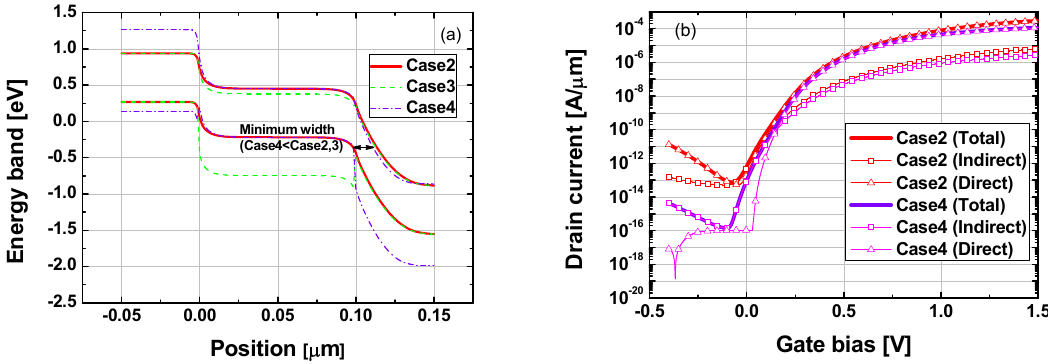
Figure 4. ( a ) Energy band diagrams for comparing Case2–Case4 at off-state ( V GS = − 0.4 V, V DS = 0.95 V). ( b ) Indirect tunneling, direct tunneling and total drain current of Case2 and Case4 structures.